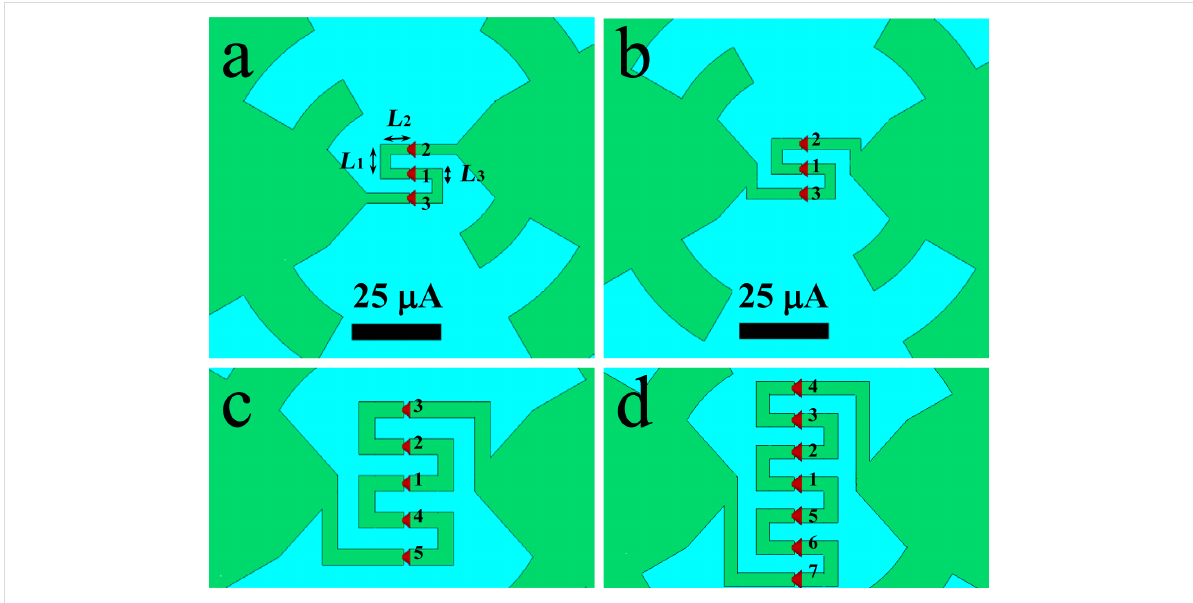
Figure 3: Geometry of log-periodic antennas with a meander series of Josephson YBaCuO grain boundary junctions. (a) Displaced geometry with three ports; (b) unchanged antenna with long meander and three ports; (c, d) antennas with five and seven ports, respectively.